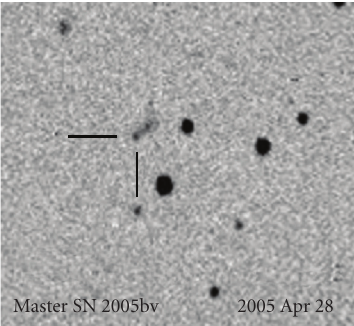
Figure 2: The first supernova discovered in Russia (SN2005bv).